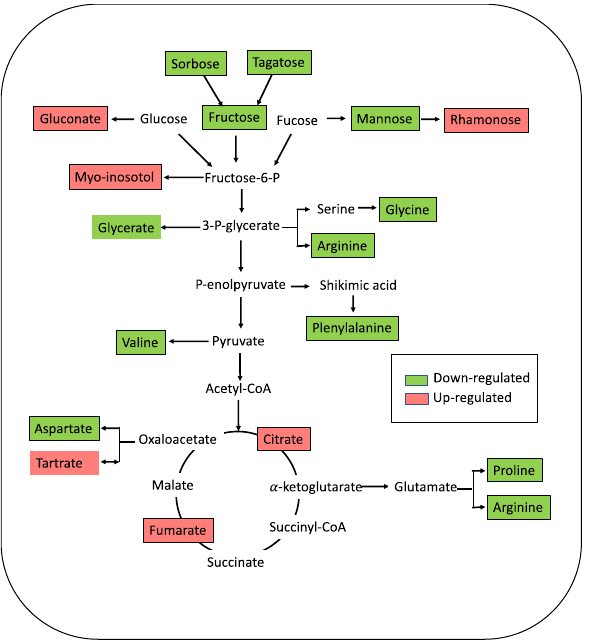
Figure 3. Metabolic changes involved in the lettuce crops amended OFMSW and SM fertilizers in comparison with control crops amended with CF. The significantly up- and down-regulated ( p < 0.05) metabolites are indicated in red and green respectively. Figure was created with Microsoft PowerPoint (version16.6.6, https:// www. micro soft.